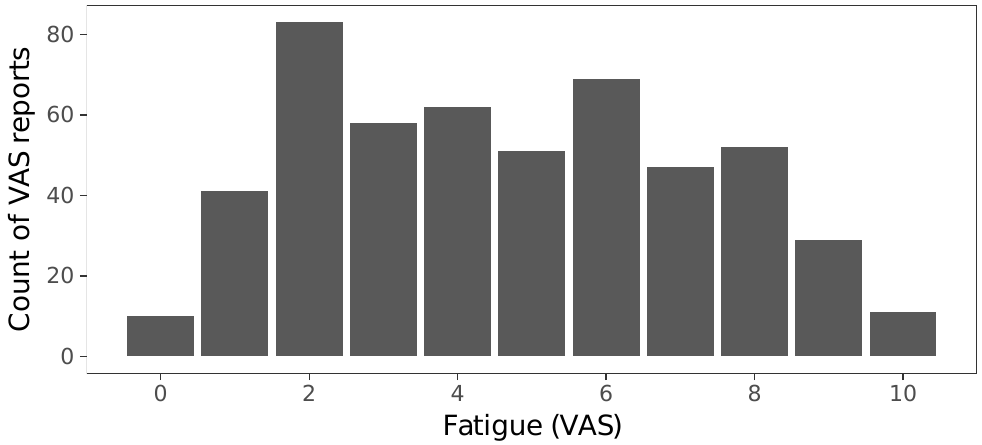
Figure 7. Histogram of Fatigue (VAS) shows the count of fatigue values reported by all patients through the smartphone VAS. Peaks for the even numbers 2, 4, 6, 8 indicate a bias through the app design (ref. Figure